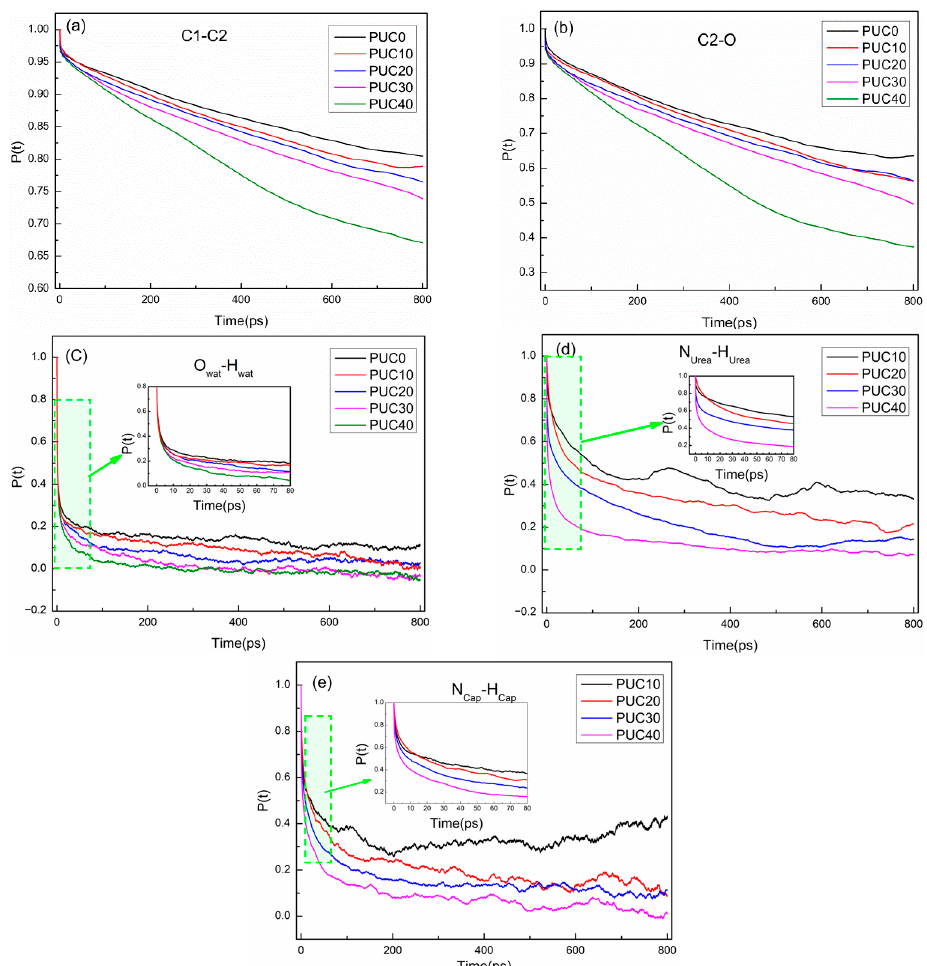
Figure 9. The evolution of the rotational time correlation functions over time. ( a ) C1-C2 vector, ( b ) C2-O vector, ( c ) O Wat -H Wat vector, ( d ) N Urea -H Urea vector and ( e ) N Cap -H Cap vector.